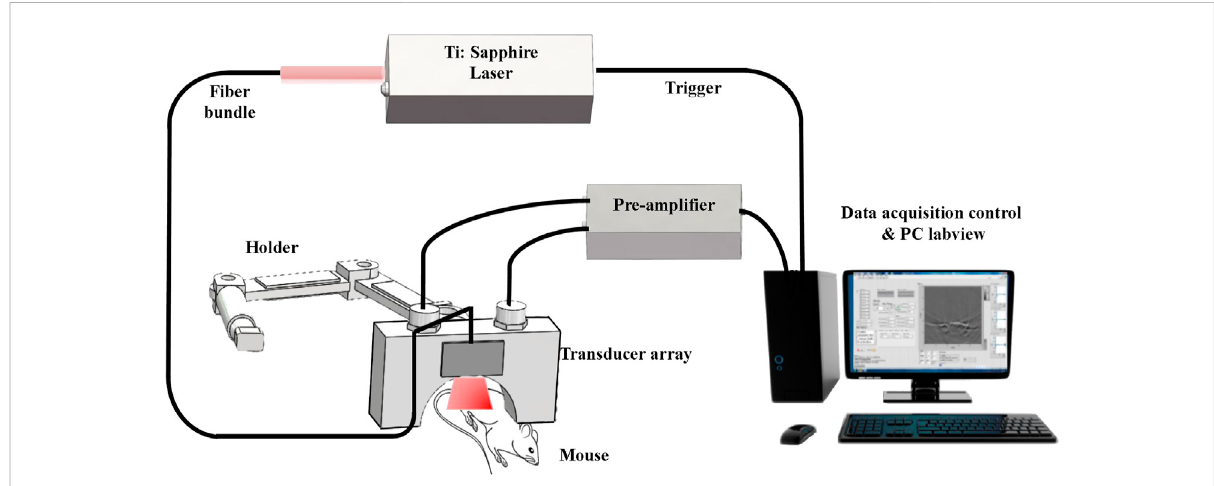
FIGURE 2 Schematic of our OAI system for in vivo imaging tumor-bearing